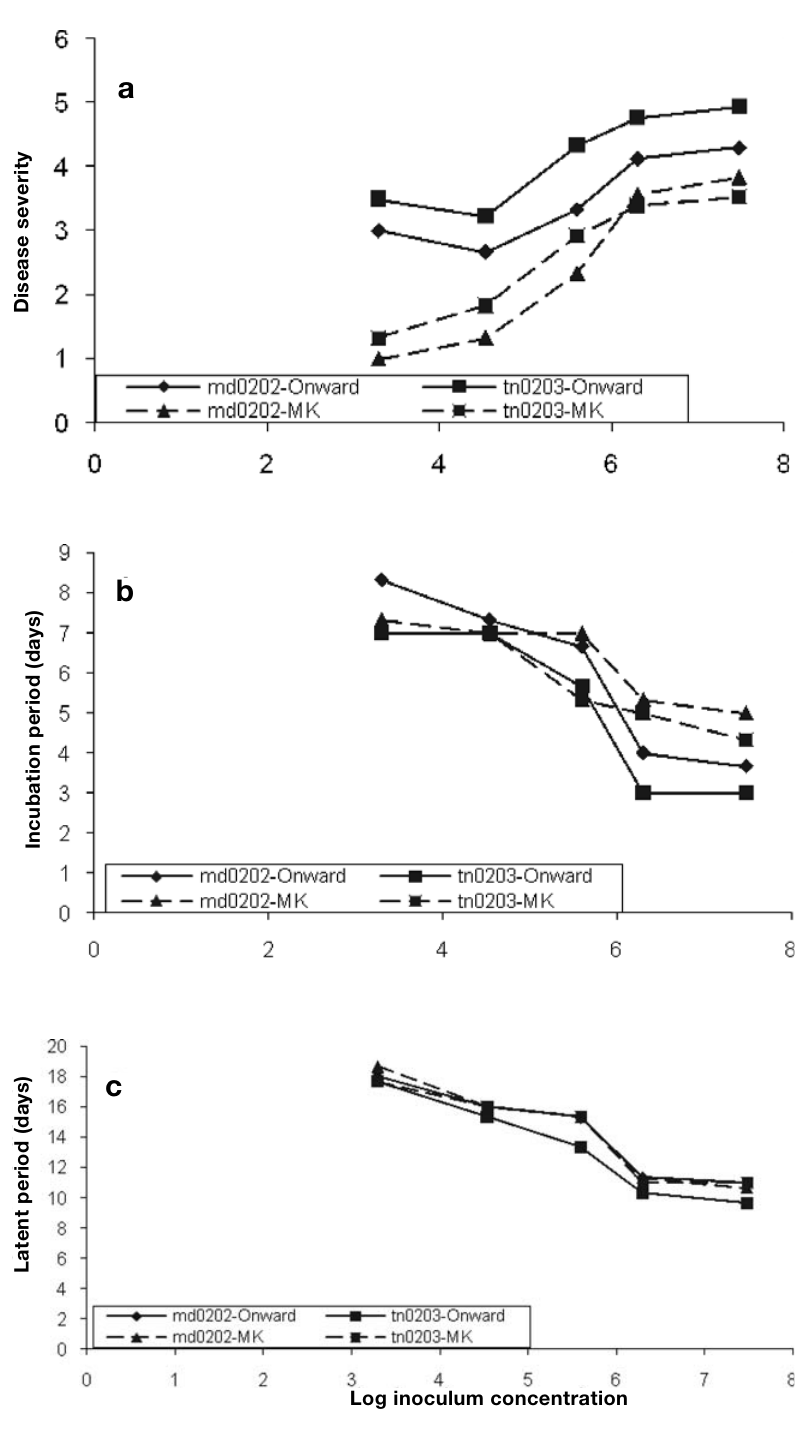
Fig. 1. Effect of log inoculum concentration in Mycosphaerella pinodes isolates md0202 and tn0203 inoculated on pea cv. Onward and Merveille de Kelvedon: a) disease severity; b) latent period; c) incubation